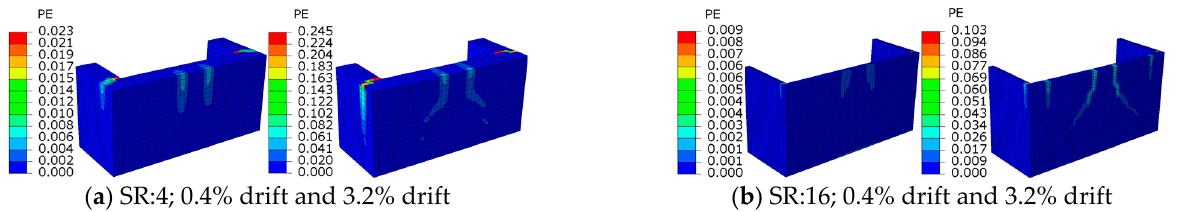
Figure 14. The influence of the slenderness ratio (SR) on the strain distribution of the wall.